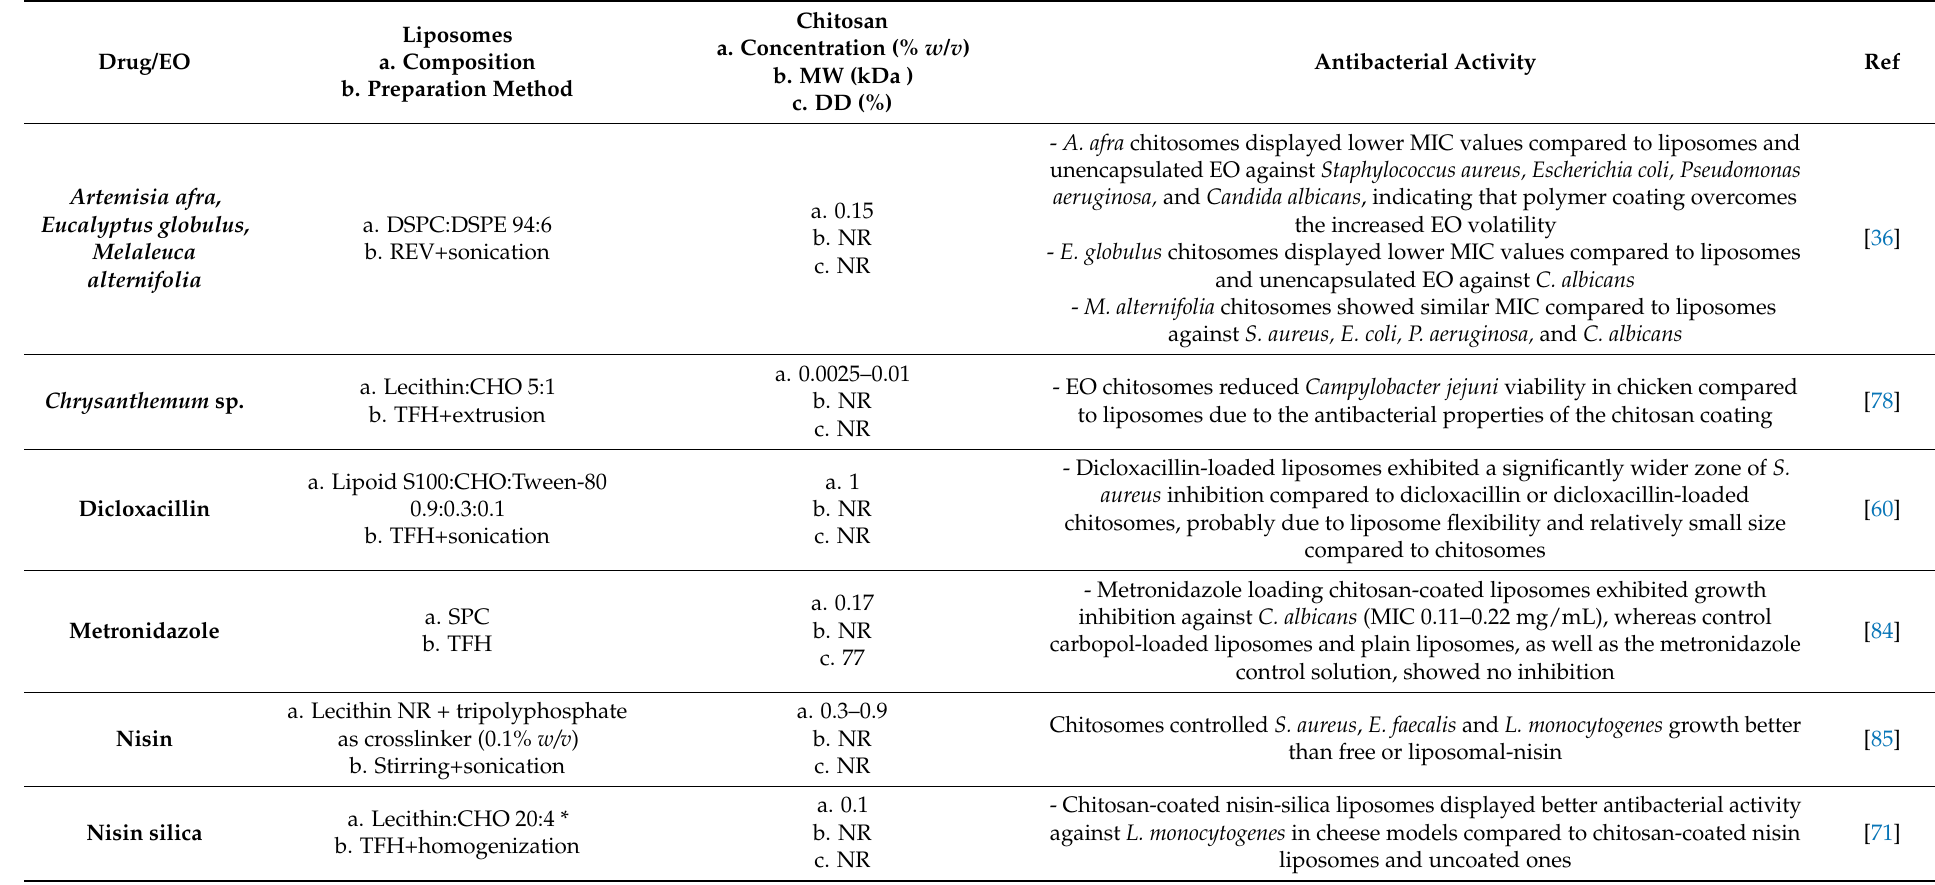
Table 8. Antimicrobial activity of bioactive molecules: conventional liposomes and chitosomes. The liposomal composition is indicated in the table in molar ratio except when * exists, indicating a weight ratio ( w/w